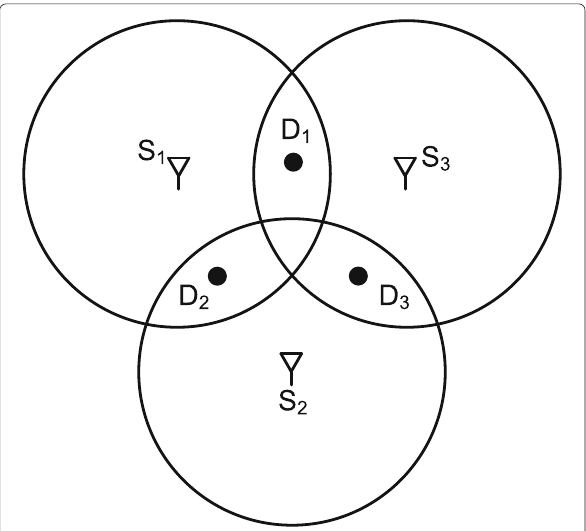
Fig. 7 Downlink cellular network with three base stations and